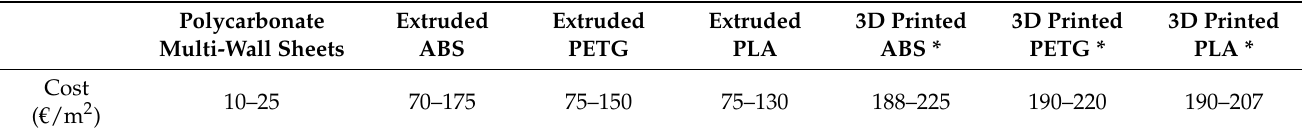
Table 7. Costs per square meter of plastic and polymer materials used as a second-skin layer in this research [54,77–79]. Polycarbonate Multi-Wall